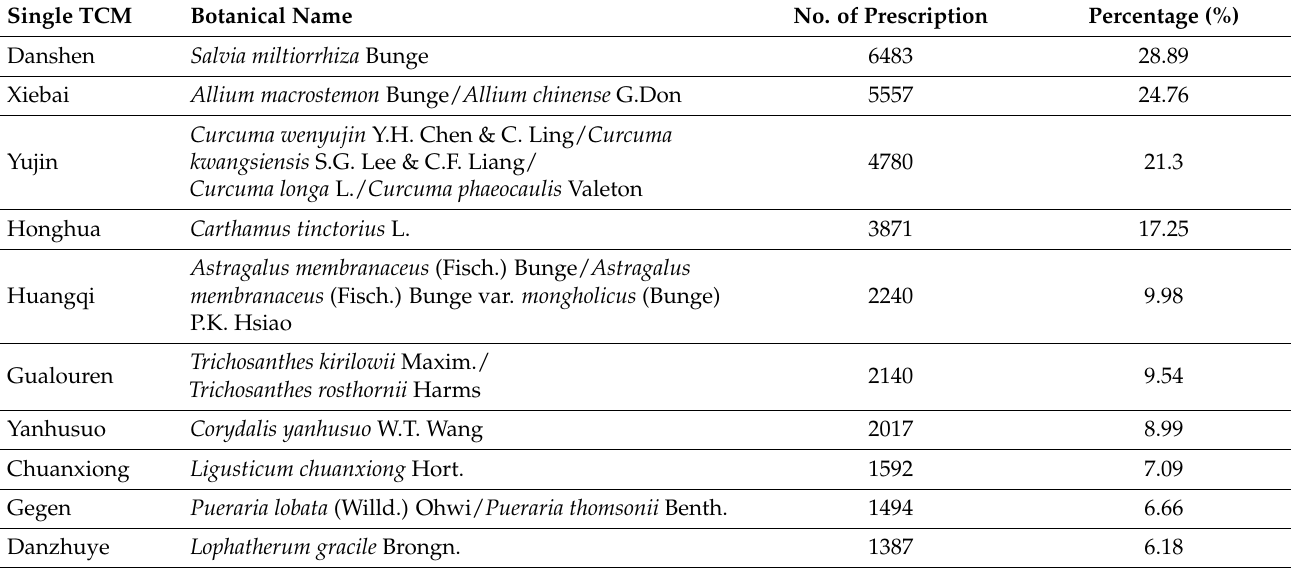
Table 2. The top 10 single TCMs prescribed for IHD in Taiwan during 2000–2017. Total prescription number, n = 22,441.